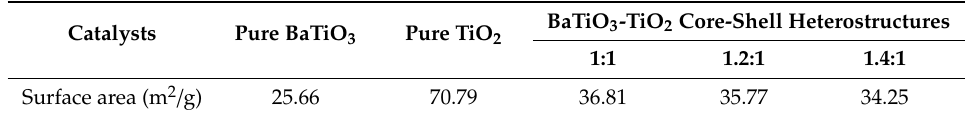
Table 1. Surface areas of the samples.